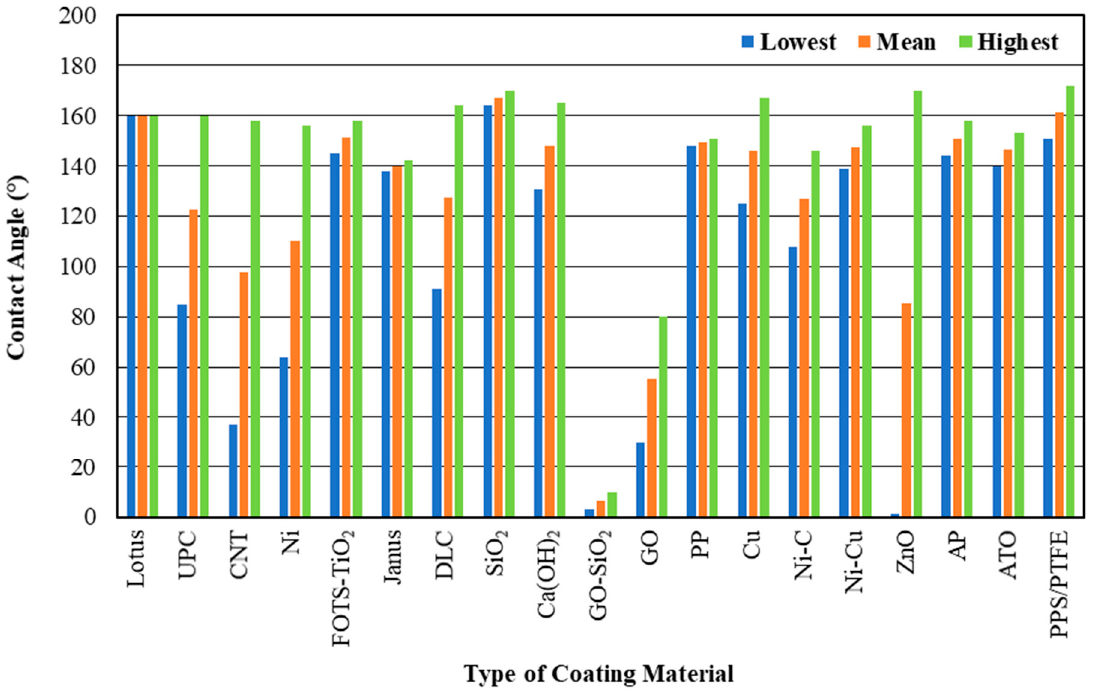
Figure 6. An analysis of the recorded contact angles for various coating materials. Any contact angle >150° is considered on a par with that of the lotus leaf.